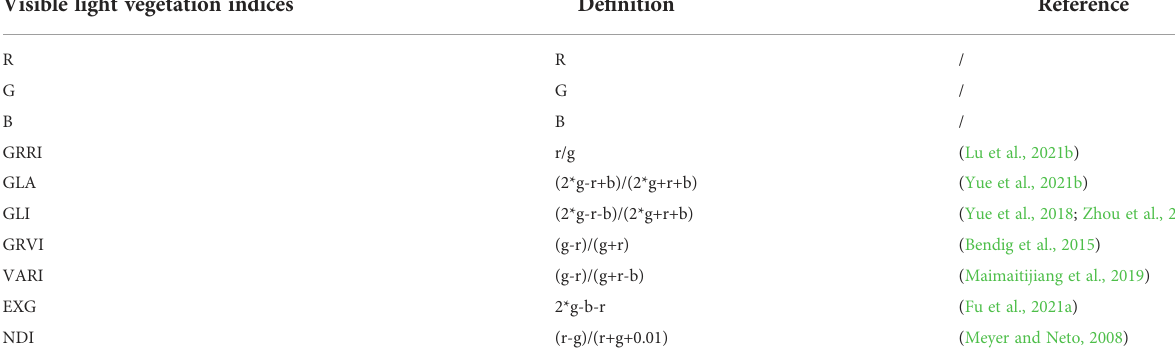
TABLE 2 Visible light vegetation indices related to nitrogen. Visible light vegetation